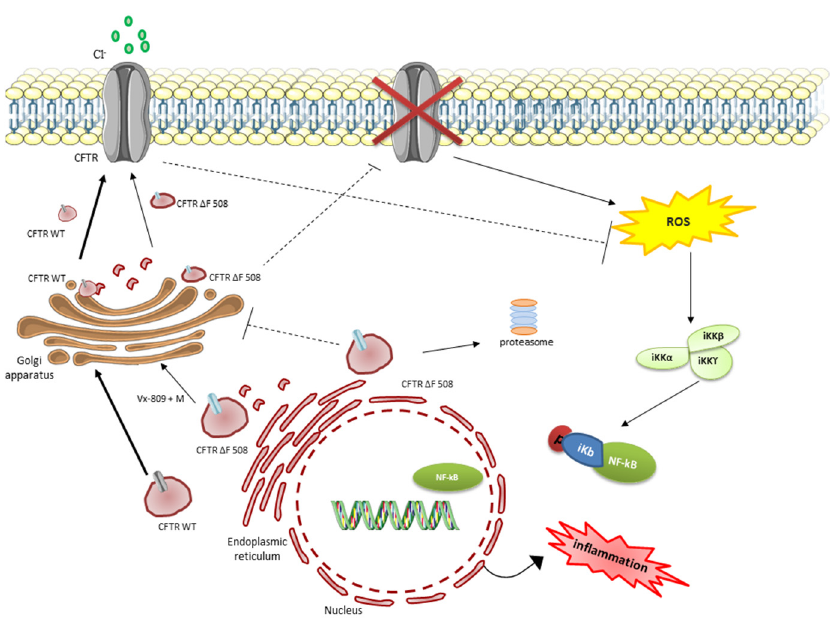
Scheme 1. Effect of Vx-809 and Matrine co-administration on folding, trafficking, and